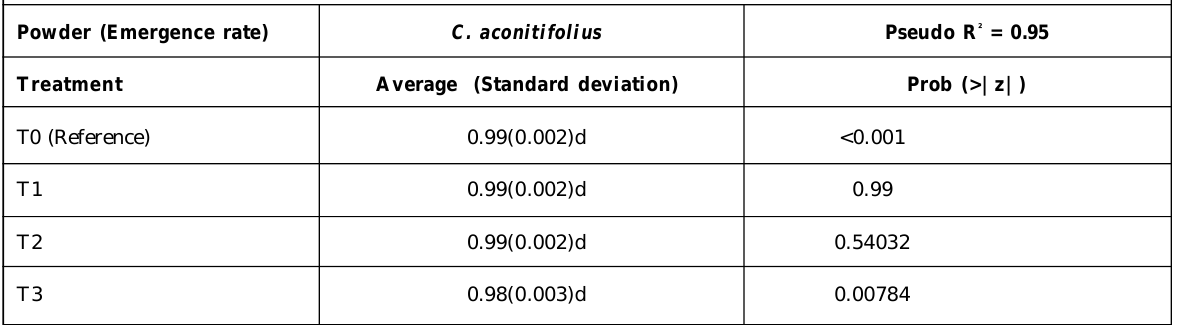
Table 7 : Result of beta regression applied to emergence of C. maculatus under the effect of powder of C. aconitifolius Powder (Emergence